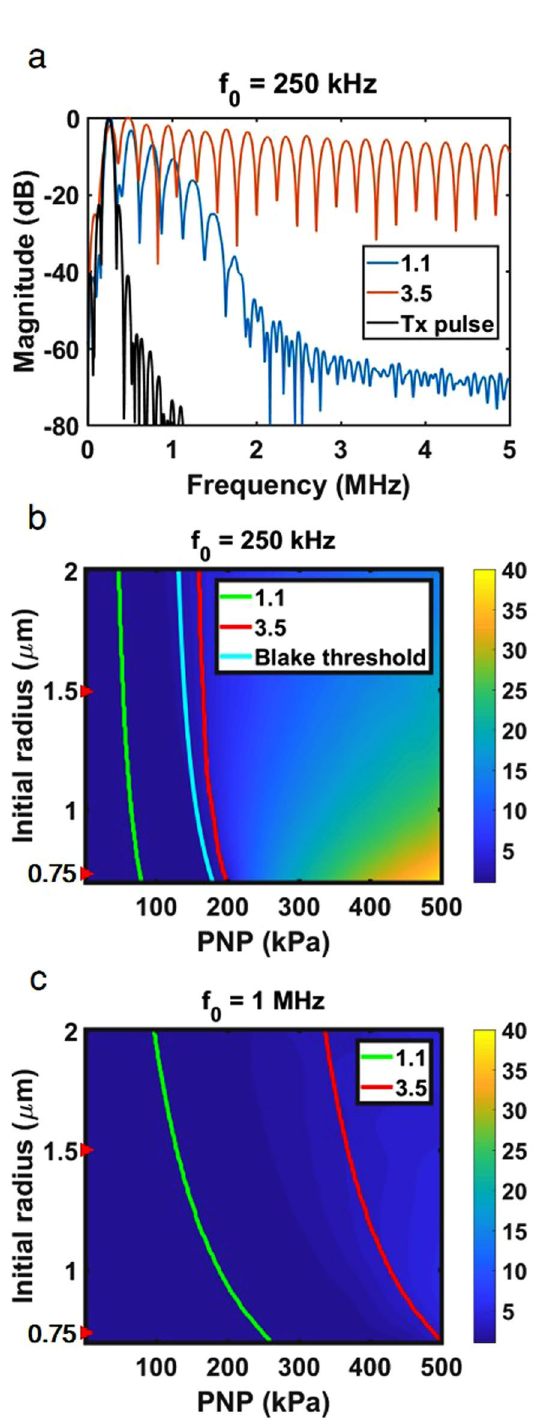
Figure 2. Theoretical predictions using the modified Rayleigh-Plesset Equation of MB oscillation at 250 kHz and 1 MHz with a three-cycle excitation. ( a ) Received spectrum for the transmitted pulse (Tx pulse) and echoes corresponding to 1.1-fold (75 kPa) and 3.5-fold (190 kPa) expansion following 250 kHz transmission, for 0.75 µ m radius MBs. Maximal expansion as a function of MB radius and peak negative pressure (PNP) with an expansion of 1.1 and 3.5 fold indicated by the green and red lines, respectively, and the Blake threshold by the blue line ( b ) for a center frequency of 250 kHz. ( c ) for a center frequency of 1